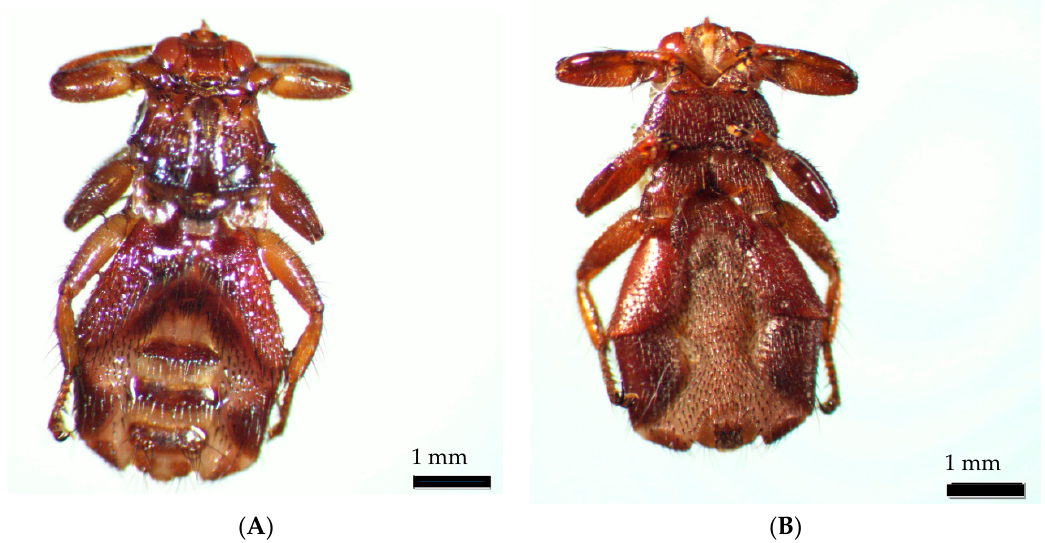
Figure 4. Lipoptena cervi female: ( A ) dorsal view; ( B ) ventral view.